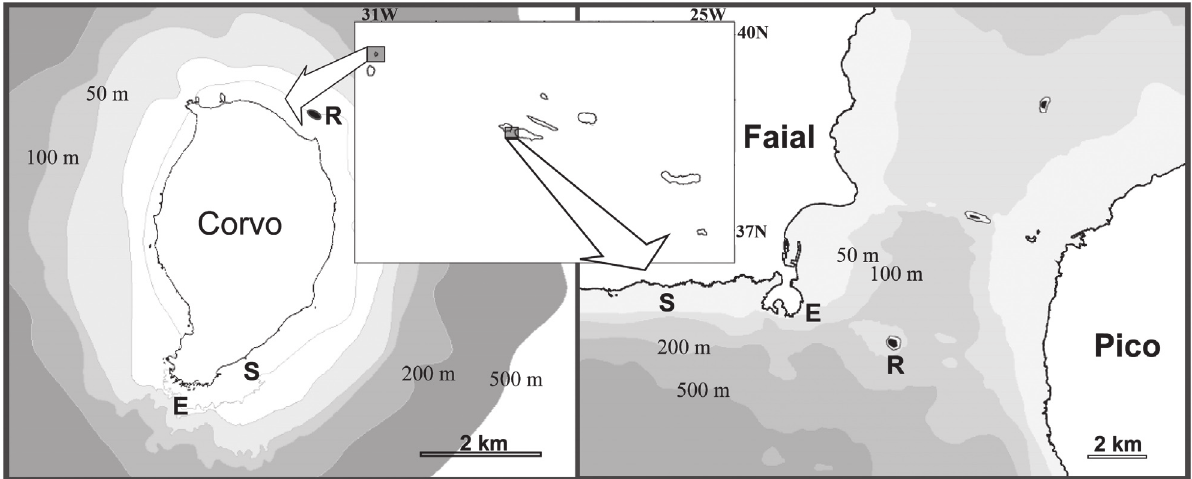
Fig . 1. – the Azores archipelago and study sites at the islands of corvo and faial: s , inshore sheltered site; e, inshore exposed site; r, offshore reef